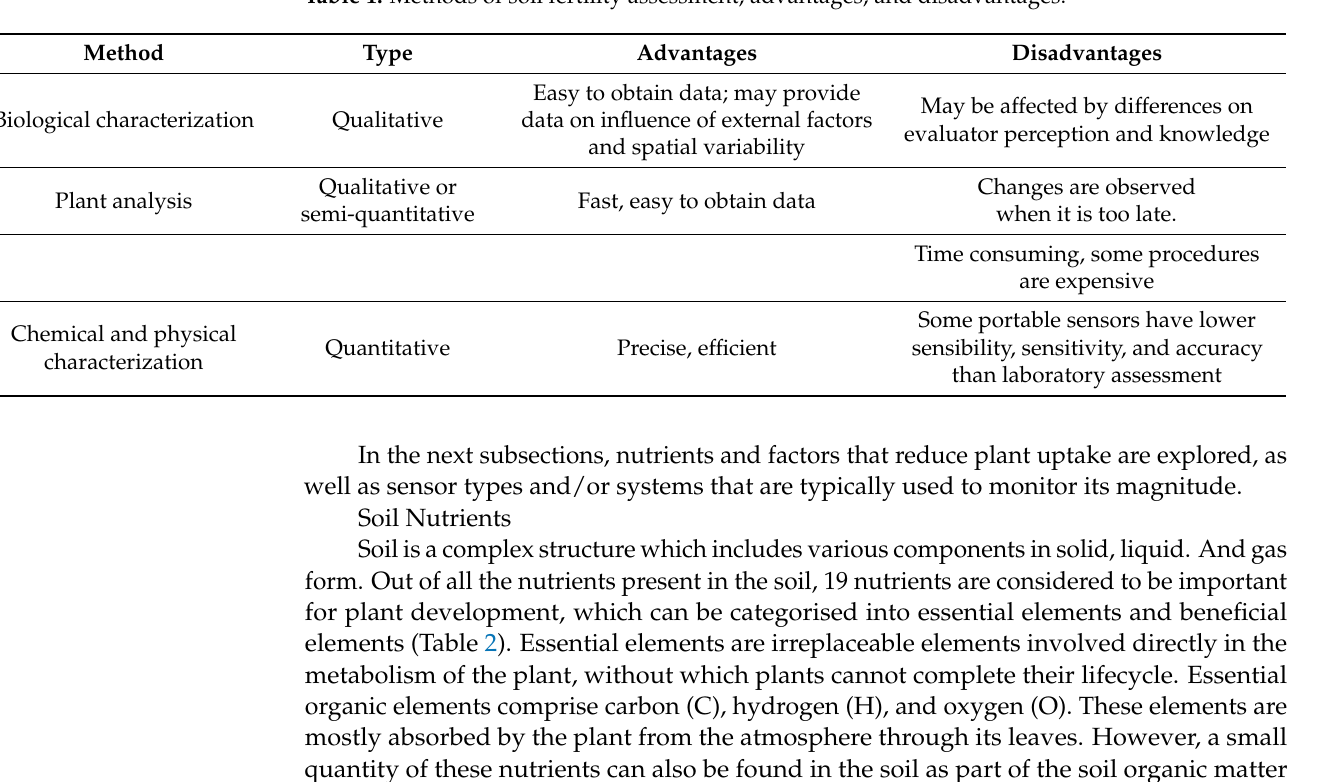
Table 1. Methods of soil fertility assessment, advantages, and